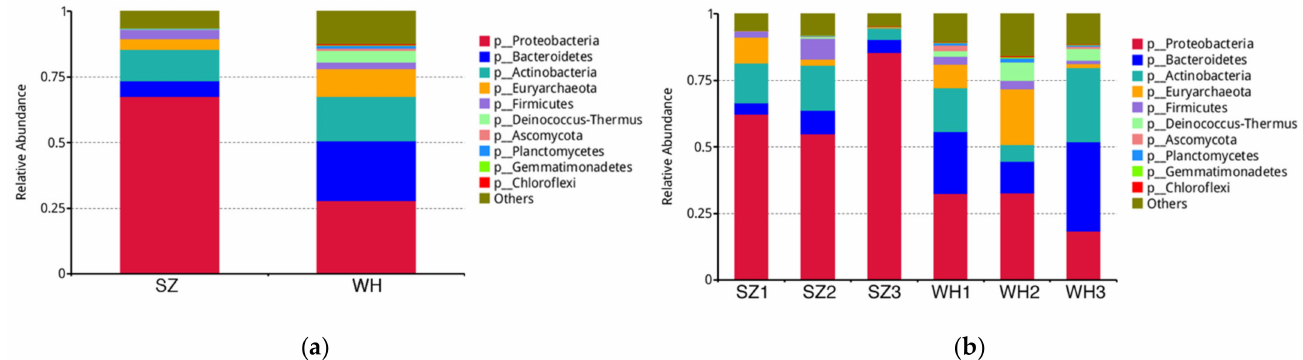
Figure 2. Relative abundances at the phylum level: ( a ) Top 10 relative abundances in both landfills at the phylum level. SZ, Suzhou landfill; WH, Wuhan landfill. ( b ) Top 10 relative abundances in each sample at the phylum level. SZ1, SZ2, SZ3 from the Suzhou landfill; WH1, WH2, WH3 from the Wuhan